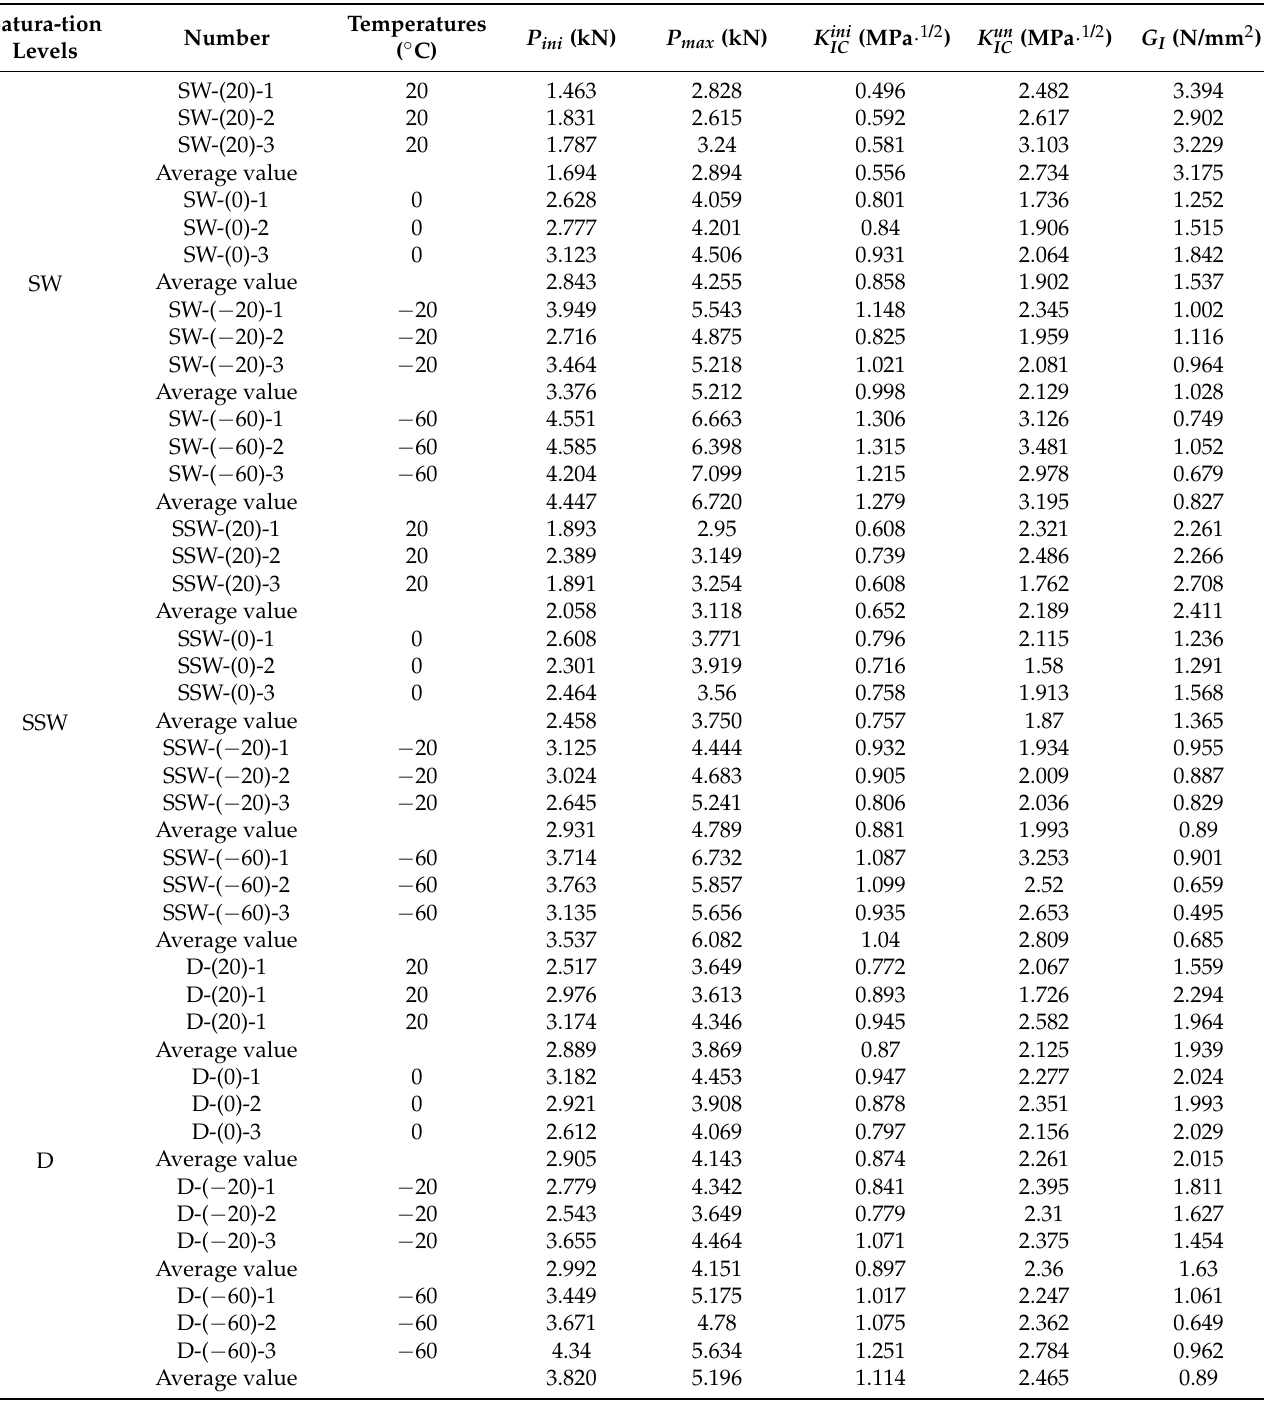
Table 5. ECC fracture properties calculation table, with three levels of saturation in four target